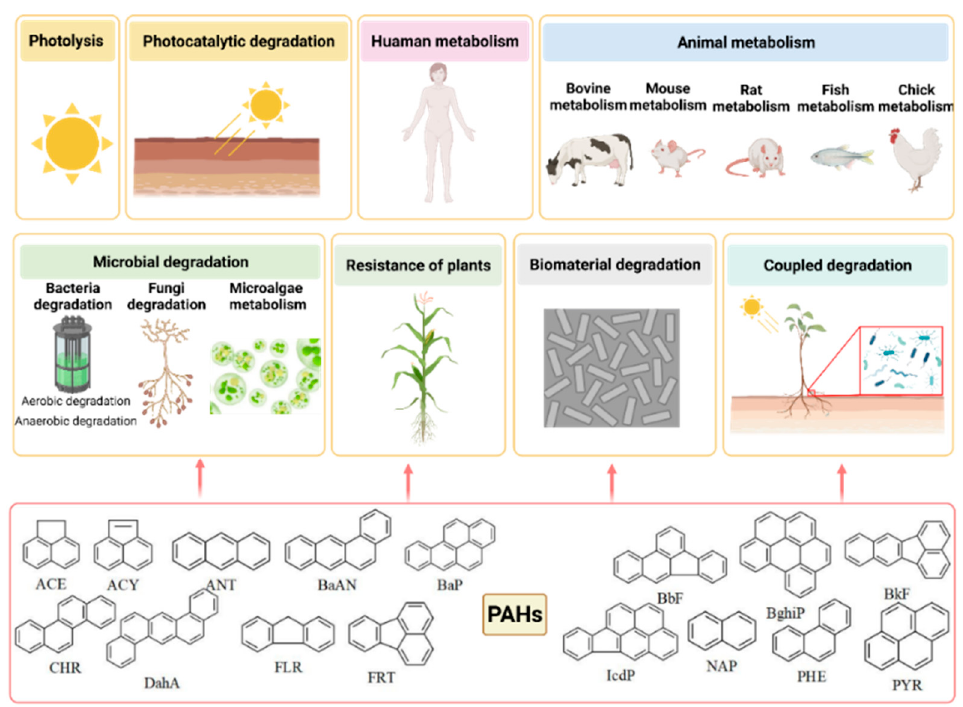
Figure 1. Schematic diagram of biological metabolism and environmental transformation of PAHs in the environment.